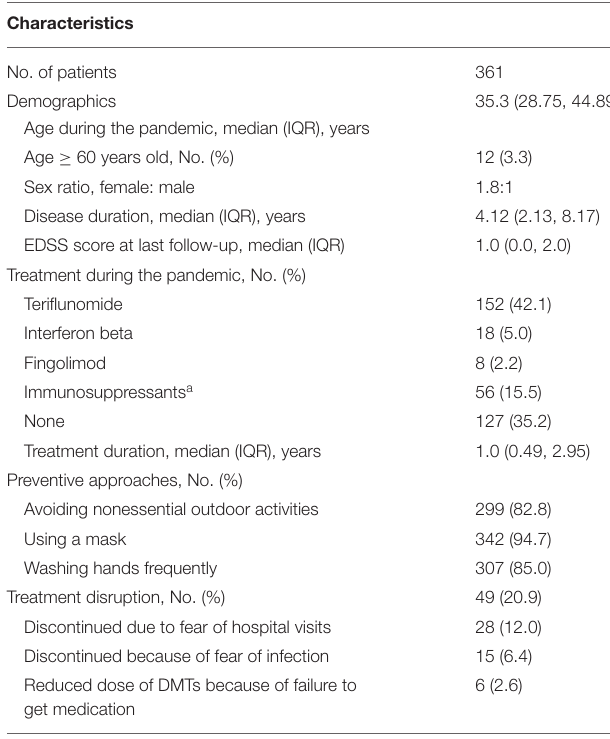
TABLE 1 | Demographic, clinical characteristics, and behavior of patients in the pandemic.